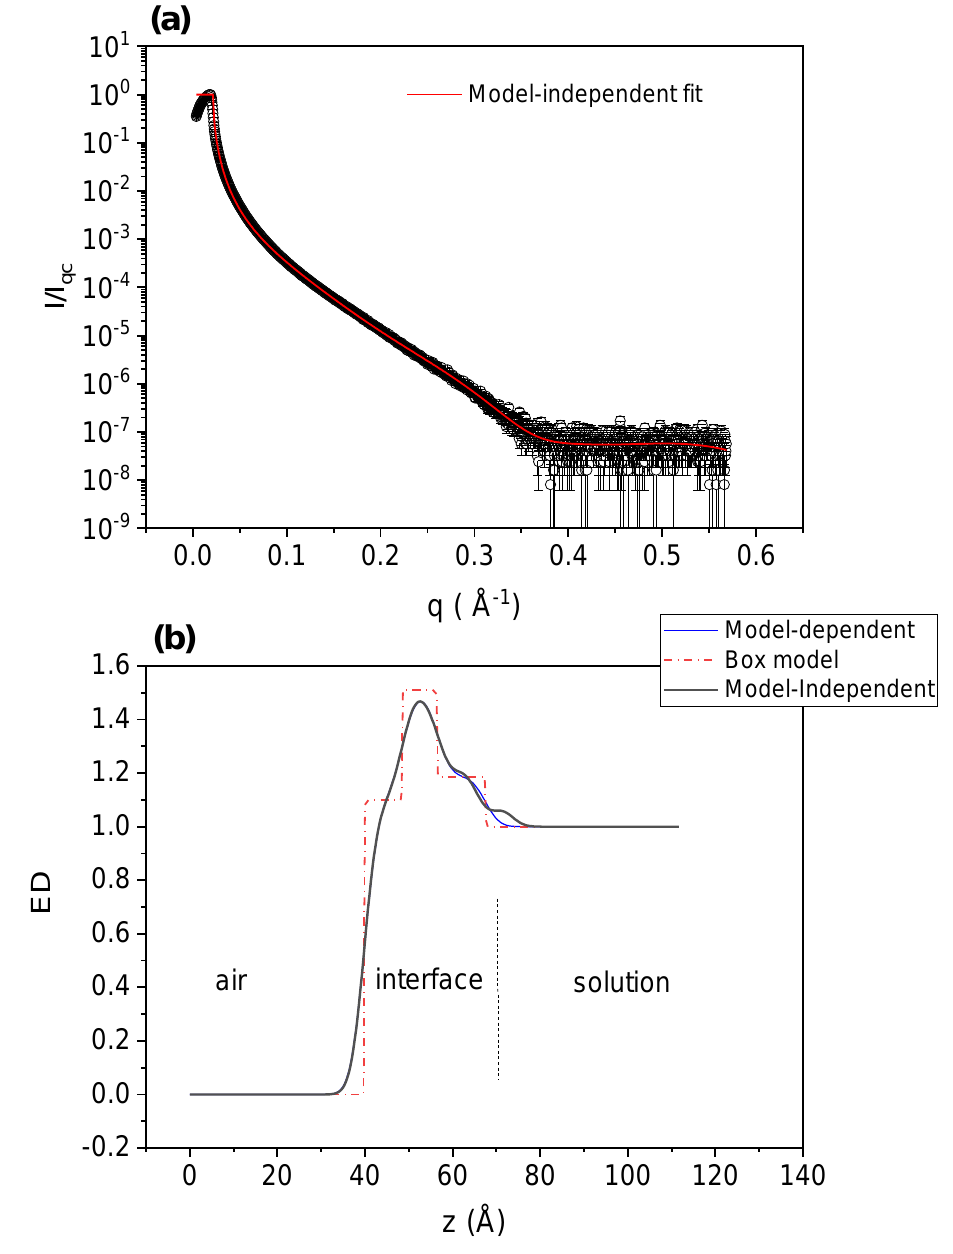
Figure 8. XRR results for G12 at a concentration of 2 mM. ( a ) Reflectivity, R = I/I qc vs. wave vector, q. ( b ) Electron density (ED) profile from a model-independent fitting ( black line ) and from a box model ( dashed red line ) fit ( dash-dot line in blue ).